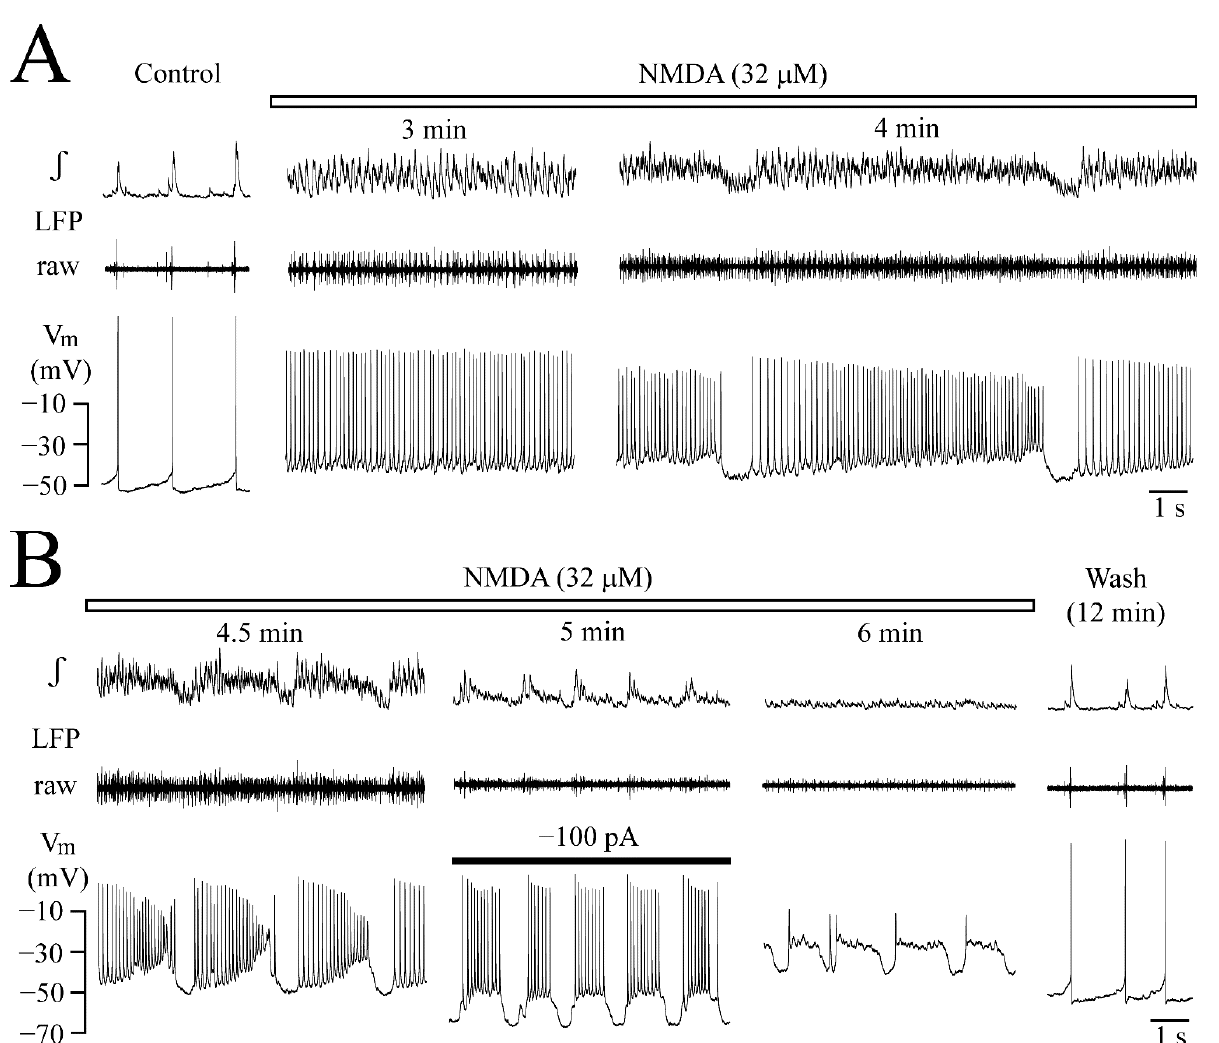
Figure 8. NMDA effects on neuronal V m . ( A ) In continuation of the recording from the neuron shown in Figure 7A (left and middle panels), NMDA-evoked V m oscillations started to become interrupted by ~1 s-lasting rhythmic hyperpolarizations causing spike blockade. The resulting LFP oscillation trains started after the inactivity period with concomitant progressive V m depolarization leading to accelerated spiking at decreased amplitude (right panels). ( B ) At 4.5 min into NMDA, LFP oscillation trains became shorter in synchrony with V m oscillation time periods (left panels). V m oscillations persisted 30 s later during hyperpolarization to − 68 mV due to dc current injection via the patch electrode. 30 s after cessation of current injection, LFP was blocked at 6 min NMDA, but tonic spiking from some neurons was still evident in the raw signal. The neuron showed at a more depolarized level V m hyperpolarizations with sharp offset evoking a small ‘rebound’ spike. Both V m and LFP recovered 12 min after start of wash.